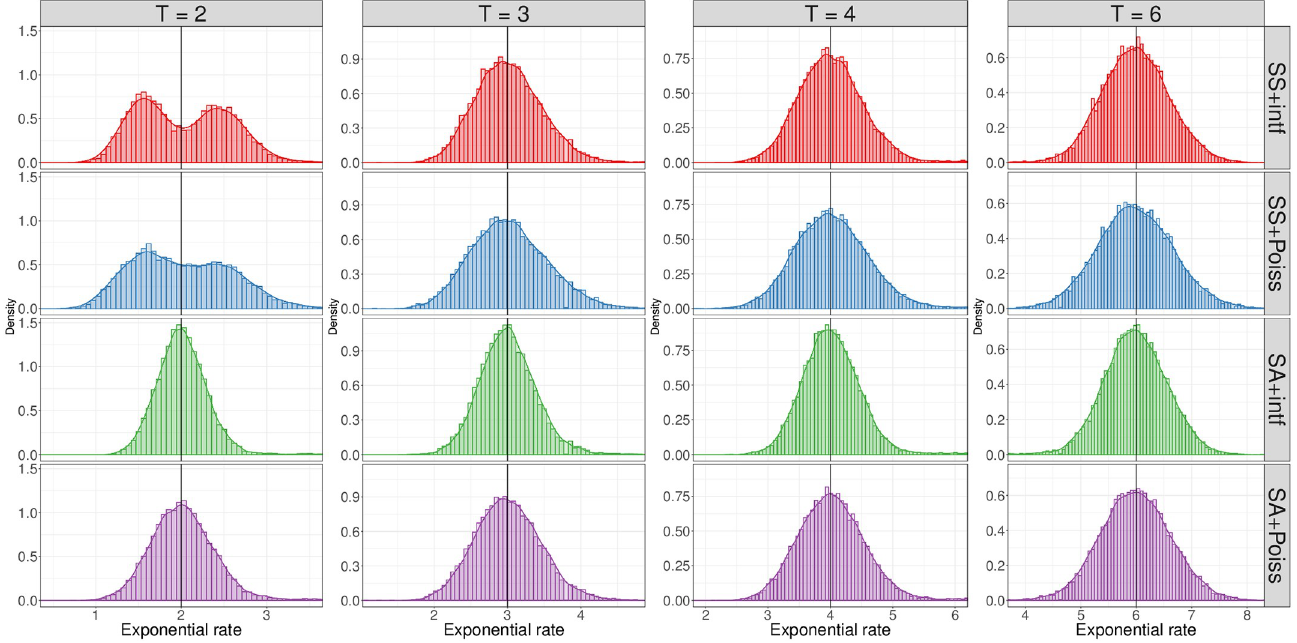
Fig 5. Distributions of estimated time since admixture based on one admixed sample. Histograms show estimated rates from 15,000 individuals simulated under each crossover model. Estimates are rate fits of an exponential distribution accounting for finite chromosomes (Methods). Horizontal lines indicate the true T .